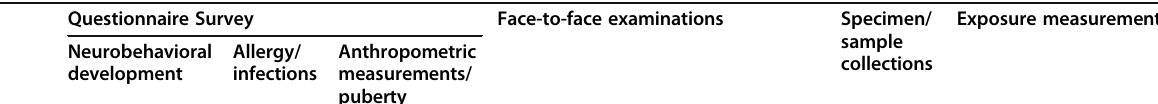
Table 2 Follow-up studies (Sapporo and Hokkaido